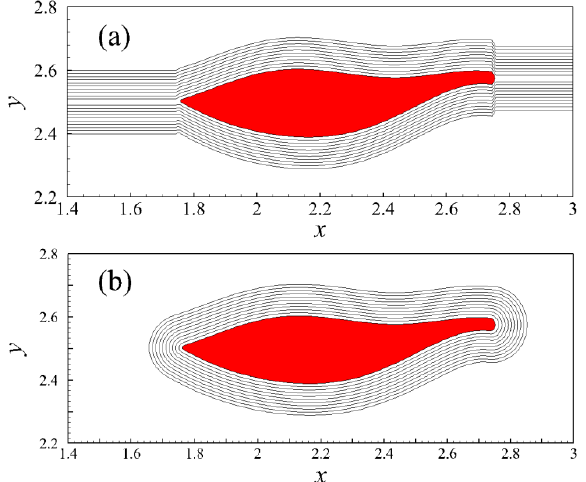
Figure 3. The value of the level set (LS) function φ : ( a ) before the re-initialization process; ( b ) after the re-initialization process.